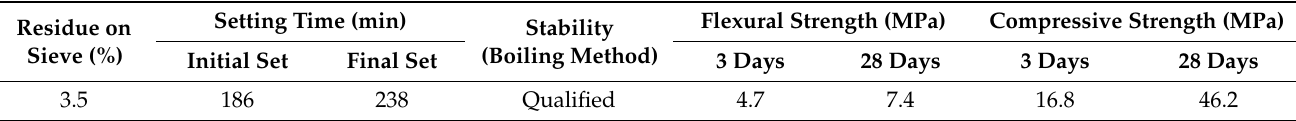
Table 1. Physical and mechanical performance of cement.